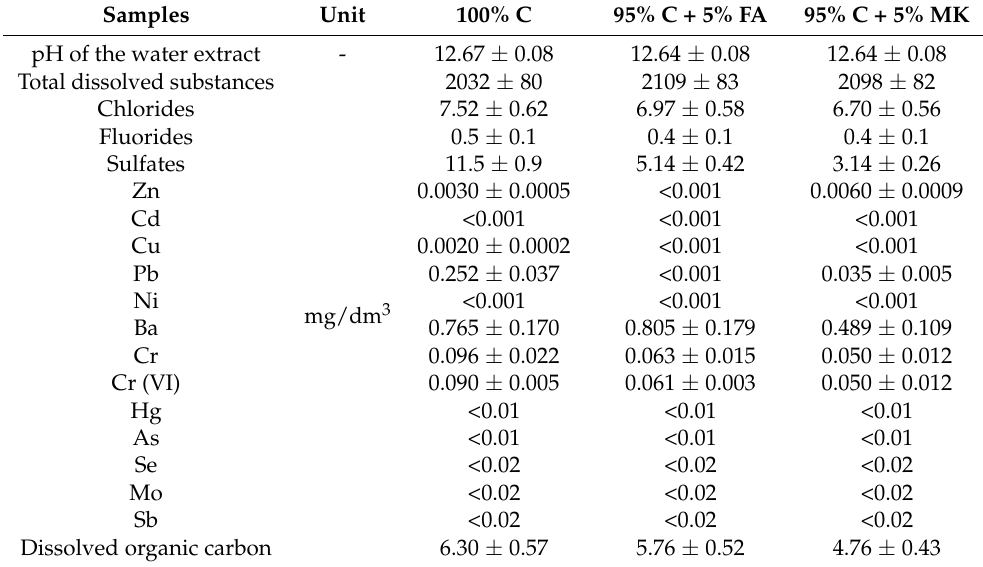
Table 4. Physico-chemical analysis of water leachates collected from concrete (100% C) and